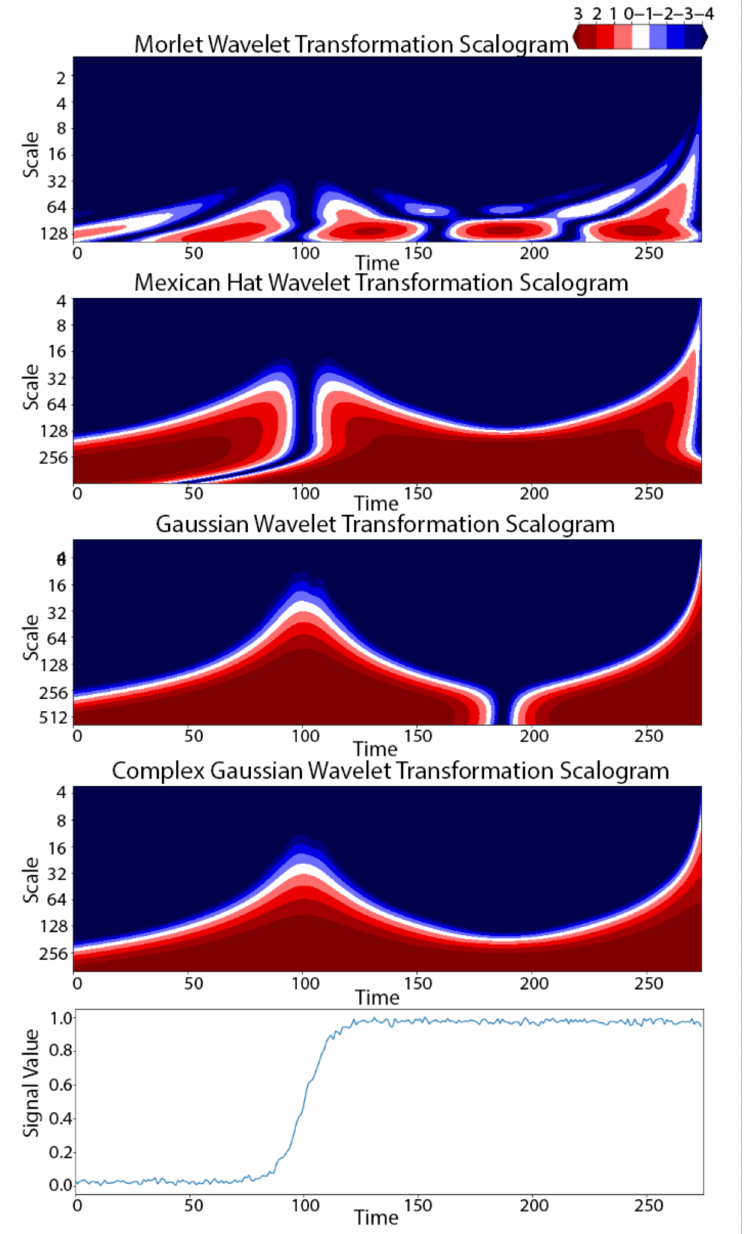
Figure 3. Scalogram representation of the 2-dimensional time-scale output of four different wavelet transformations ( top four panels ) of a single time series ( bottom panel ) from the TRACE dataset. The red color shows where the power of the transformed signal is